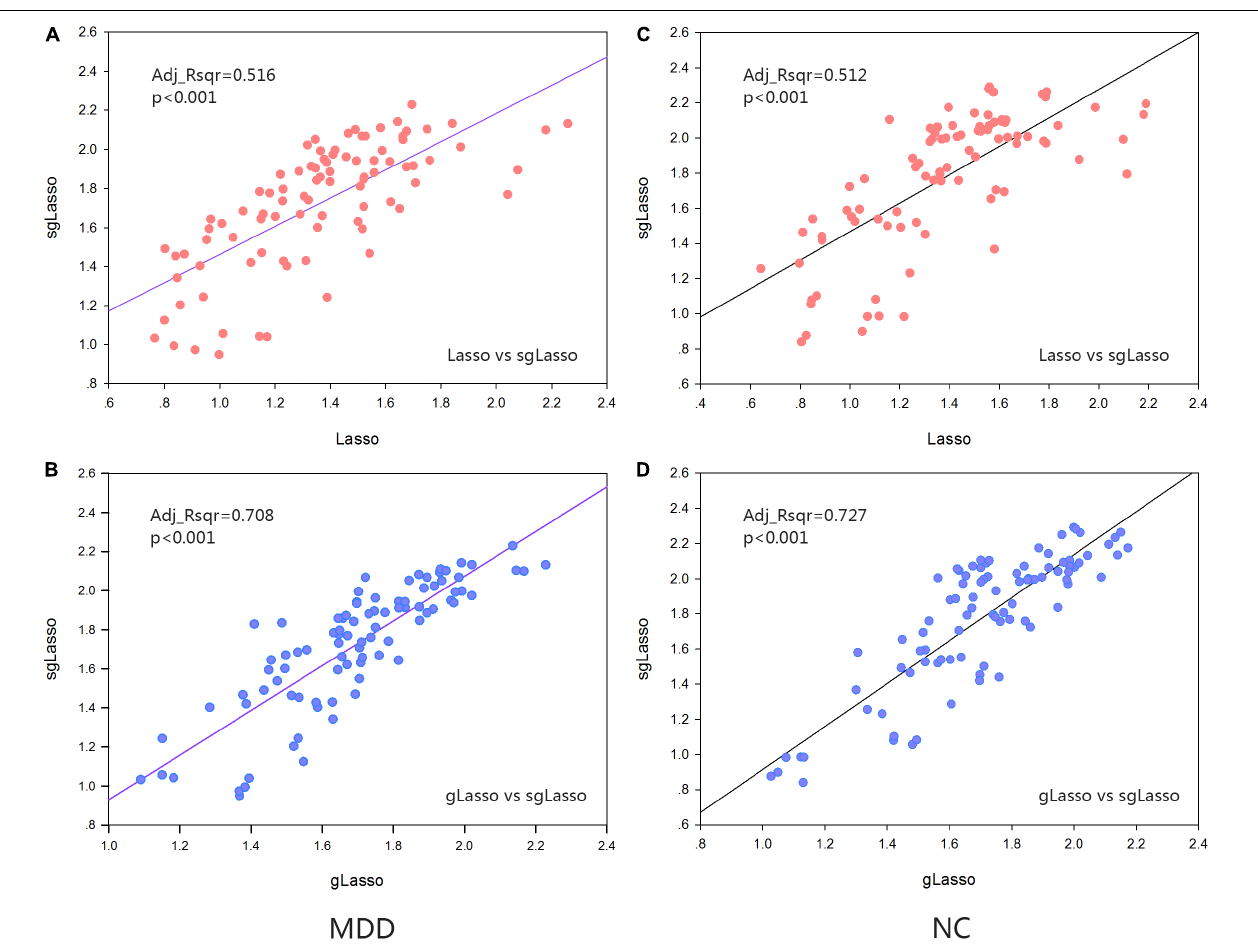
FIGURE 5 | Regression analysis about the standardized metric values about the HCC metrics. (A) Regression analysis from that obtained by sparse group lasso and lasso method in the MDD group. (B) Regression analysis from that obtained by sparse group lasso and group lasso method in the MDD group. (C) Regression analysis from that obtained by sparse group lasso and lasso method in the NC group. (D) Regression analysis from that obtained by sparse group lasso and group lasso method in the NC